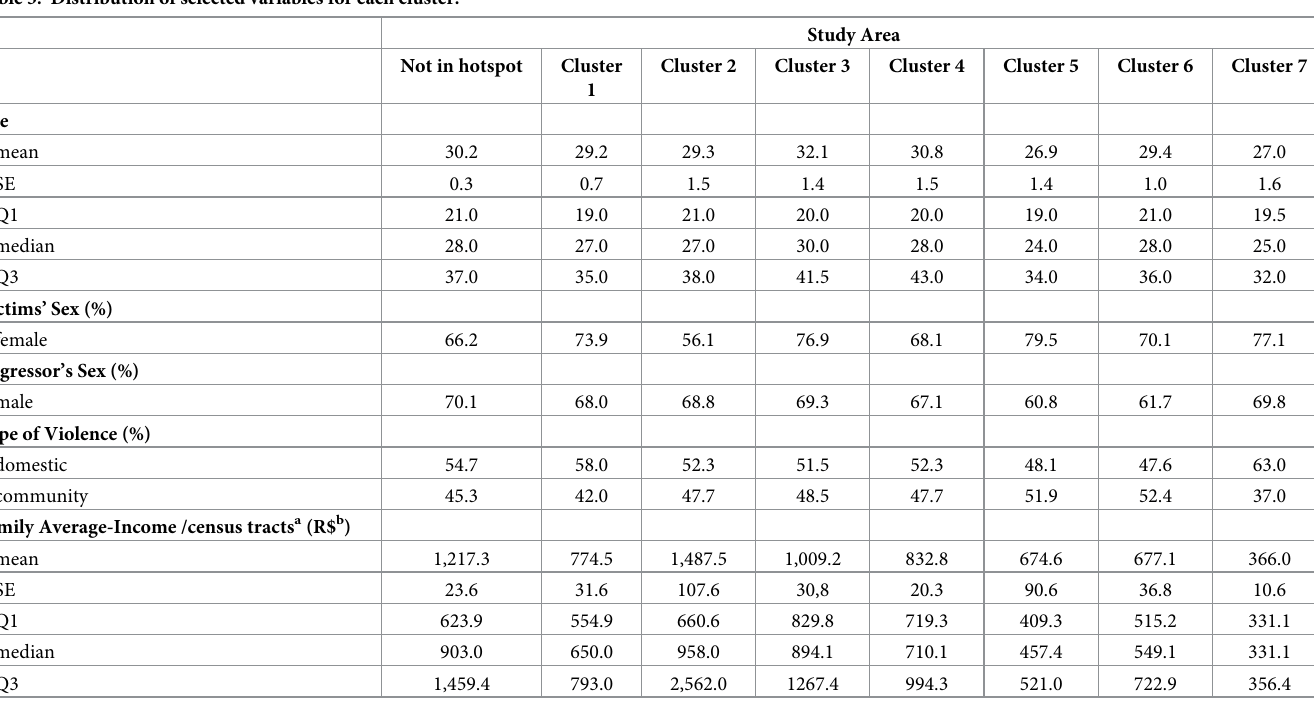
Table 3. Distribution of selected variables for each